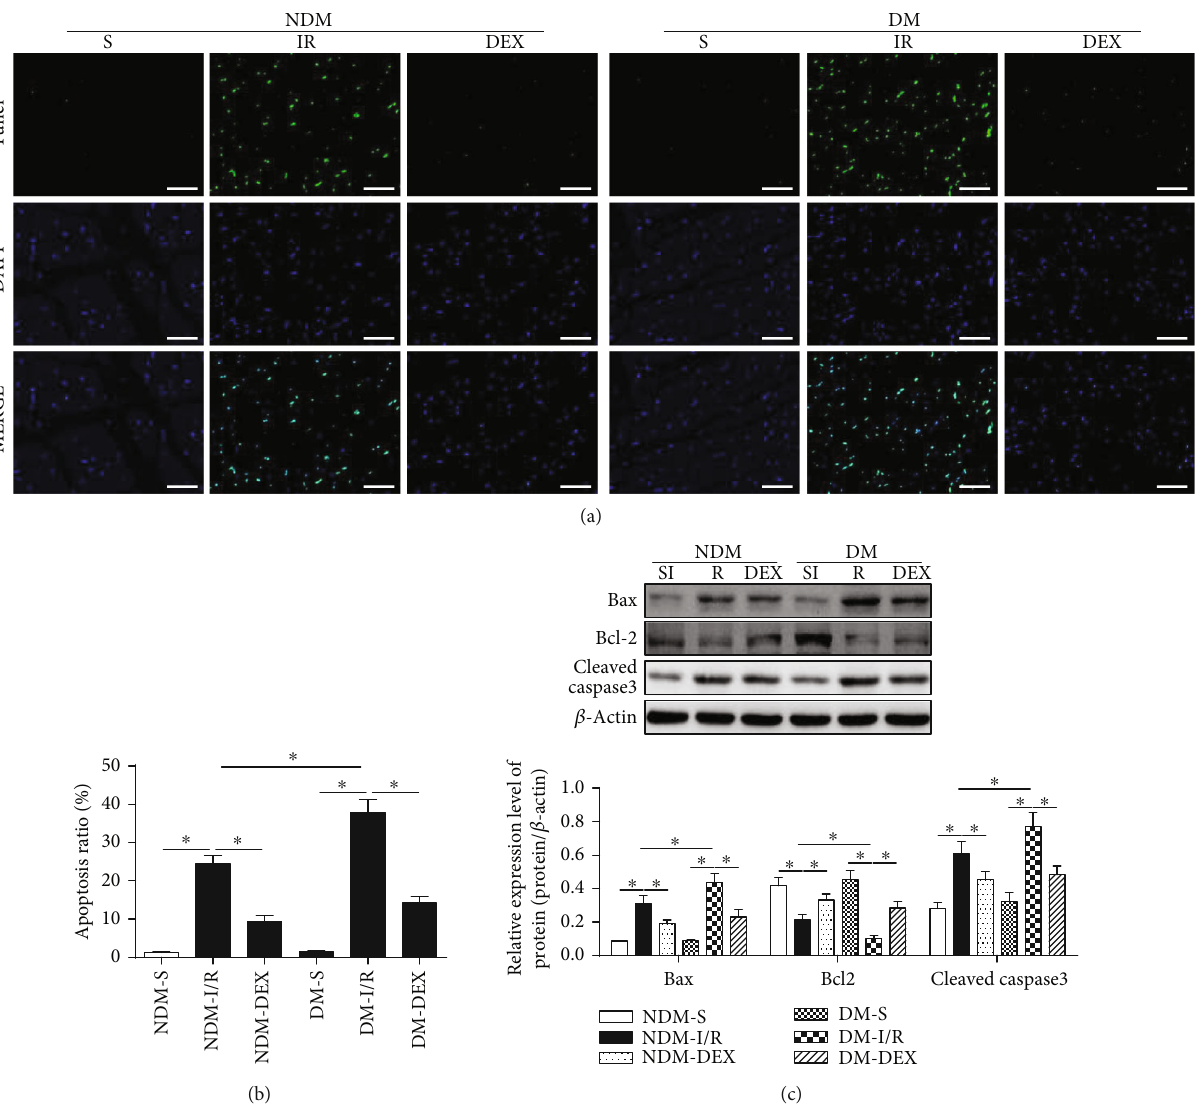
Figure 4: DEX inhibits cardiomyocyte apoptosis. TUNEL staining was used to detect the apoptosis of cardiomyocytes. (a) TUNEL staining ( scale bar = 50 μ m). (b) The bar graph of the percentage of apoptosis-positive cells. (c) Western blot. All results are expressed as the mean ± SD . ∗ P < 0 : 05 between each